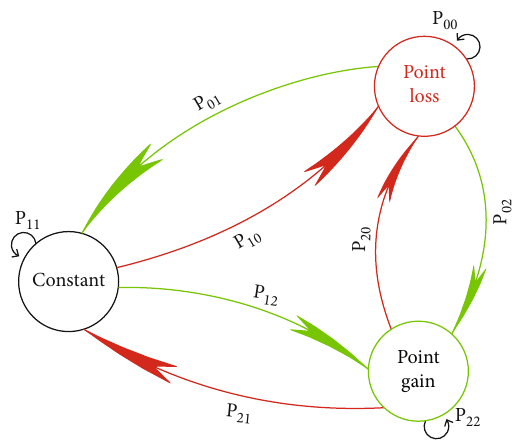
Figure 1: Illustration of a three-state transition matrix diagram or